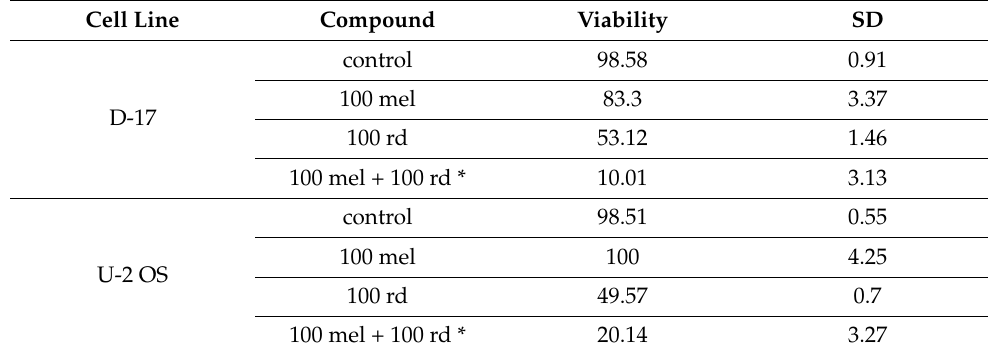
Table 4. The viability of tested compounds per se and in combinations (* p < 0.05). The cytotoxic effect of combined administration of meloxicam (mel) and risedronate sodium (rd) in doses of 100 µ g/mL compared with the negative control (control) showed statistically significant differences. The human OS cell line (U-2 OS) was more resistant to both compounds than the canine OS cell line (D-17).